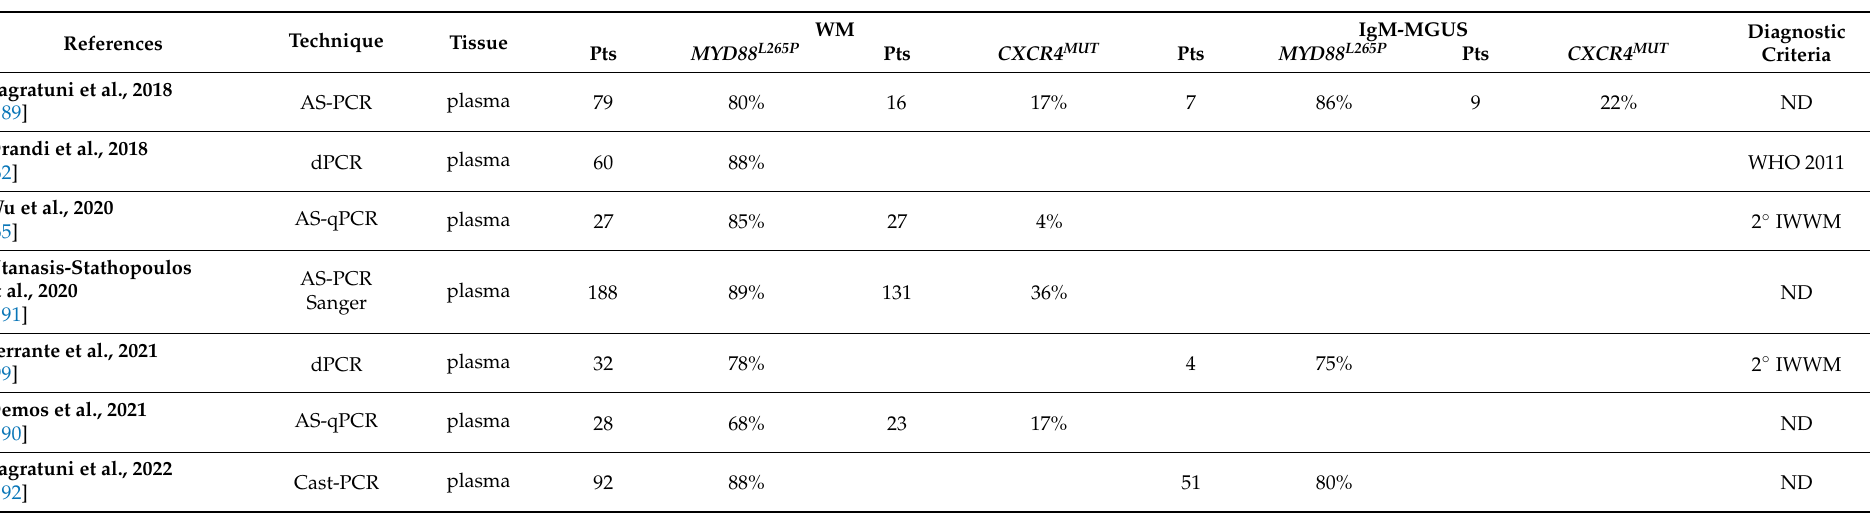
Table 6. DNA mutations detected in Liquid Biopsy studies in WM and/or IgM-MGUS. AS-PCR: allele-specific polymerase chain reaction; AS-qPCR: